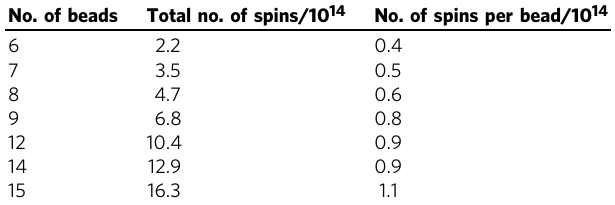
Table 2 Spin counting of the TEMPO radical signal in 7 measured at 34 GHz and room